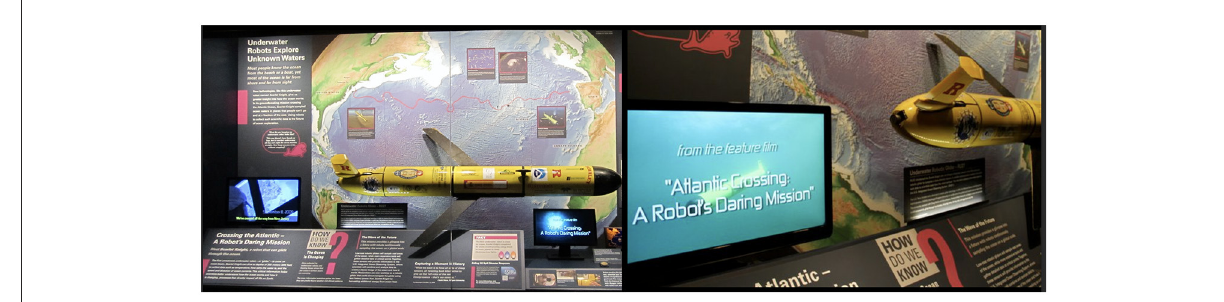
FIGURE4 Atlantic Crossing: A Robot’s Daring Mission was part of a Smithsonian Sant Ocean Hall exhibit from 2010 to 2013.